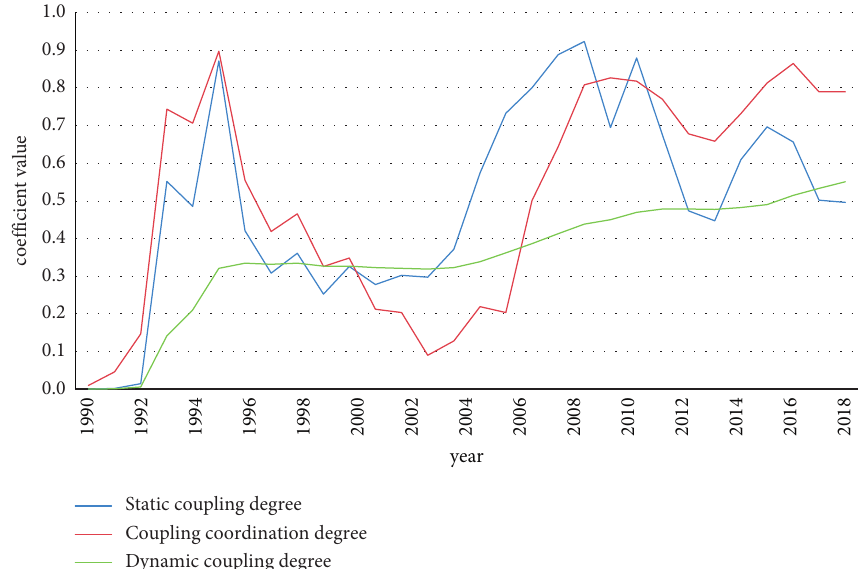
Figure 2: Static coupling degree, dynamic coupling degree, and the coupling coordination degree between SE and EE in Northeastern China,